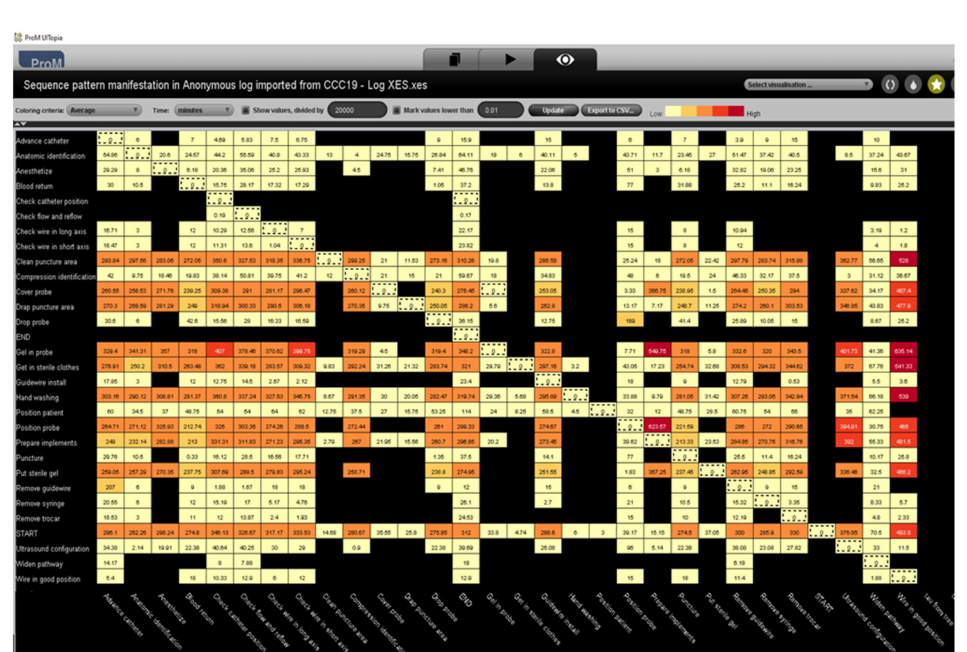
Figure 7. Transition log visualization of activities involved in CVC